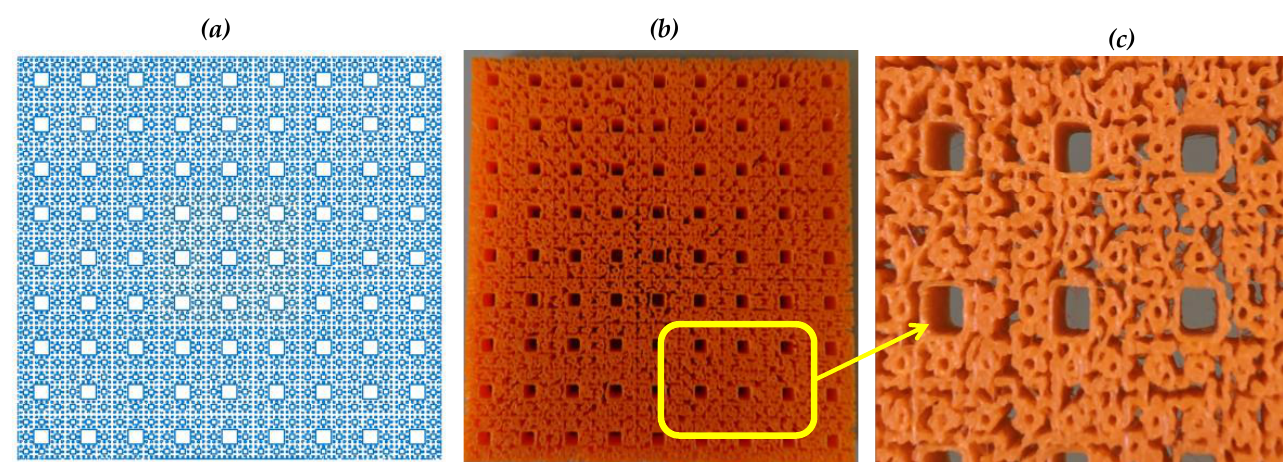
Figure 13. Point clouds controlled up to the fifth level with a filling operation and the 3D-printed porous structure: ( a ) point clouds; ( b ) 3D-printed porous structure; and ( c ) a magnified view of the printed structure.